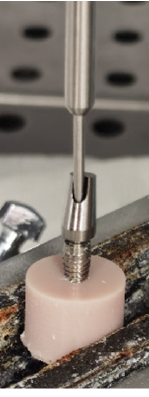
Figure 7. Fixation of group 2 “solid abutment” by using a special key percussed with a force of 200 gr. Two experimental tubes were used with nutritive solution and inoculated with 1.0 µ L of S. oralis and P. aeruginosa , respectively, as a positive control. They demonstrated bacterial growth in response to the solution’s turbulence, which supported the viability of the microorganisms throughout the experiment. Two experiment tubes that contained only a sterile nutrient solution were used as a negative control. This was supported by the transparency of the solution and conventional microbial culture